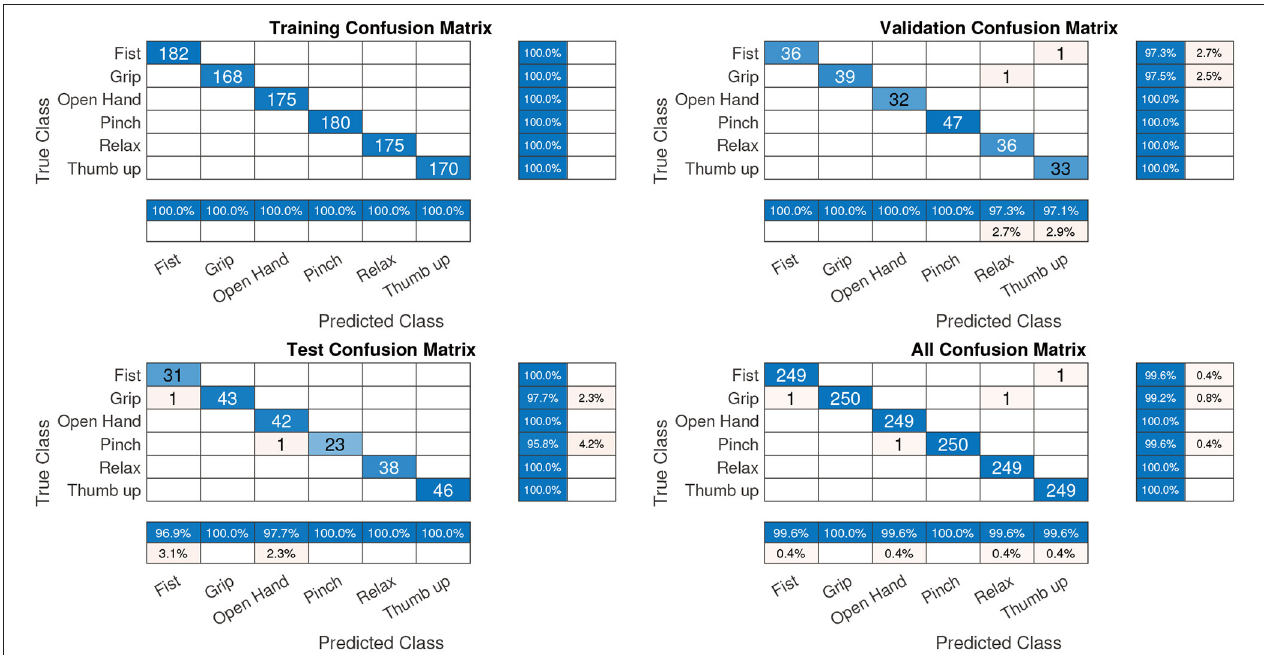
FIGURE 6 | Confusions matrix of the pattern recognition network—offline. All confusion matrixes had an accuracy of 99.7%.